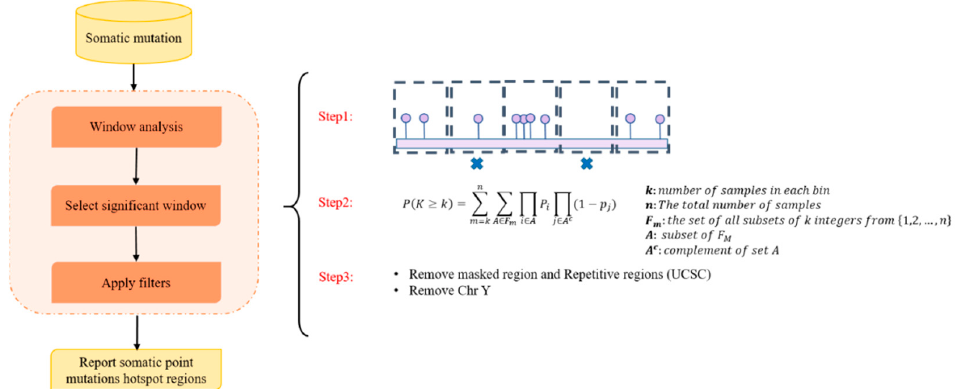
Figure 2. The schematic workflow used in this study to identify somatic point mutation hotspot regions. This analysis consists of three main steps: (1) window analysis, (2) selection, and (3) filtering. In the first step, the tool divides the genome into 21bp bins and then counts the number of samples with at least one SPM that overlaps with the window. In the selection step, a Poisson binomial distribution is used to select significant bins ( p -value < 0.05). Lastly, in the filtering step, the problematic hotspot regions and chromosome Y are excluded from the final list of hotspot regions.